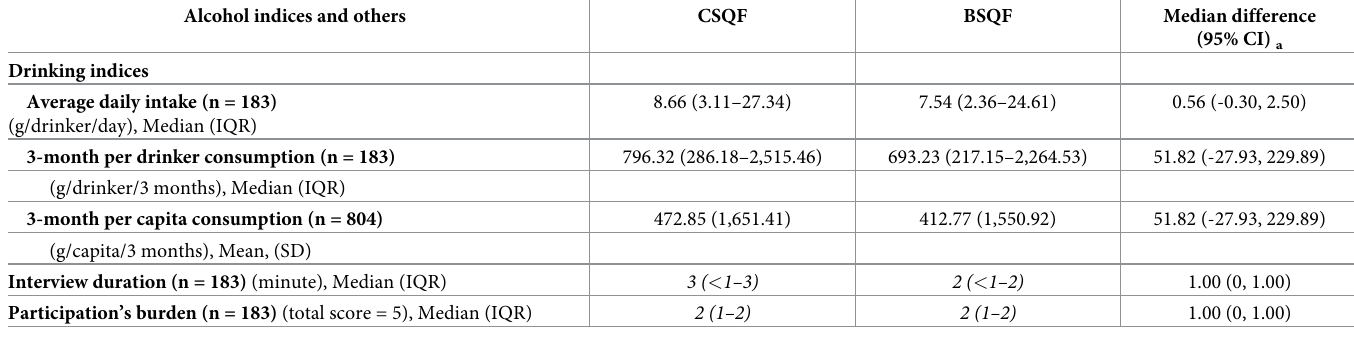
Table 5. Summary drinking variables by measurement instruments (BSQF and CSQF; n = 804 with 183 current